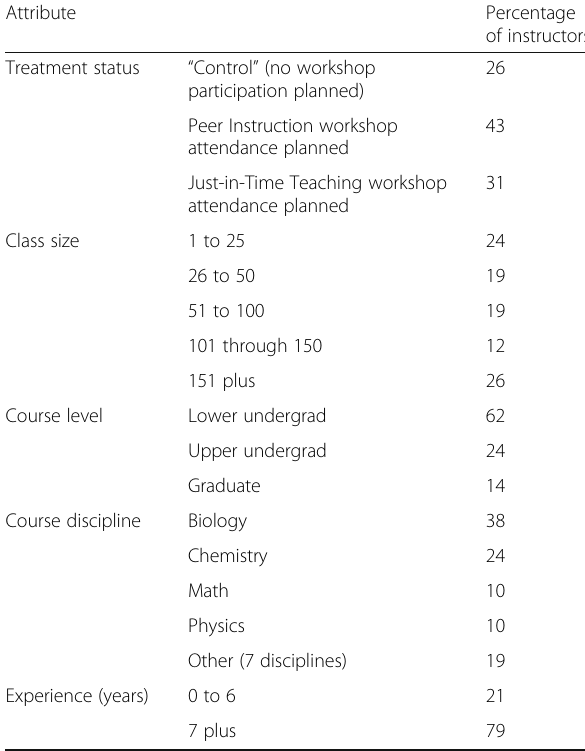
Table 1 Attributes of instructors under study ( n = 42) Attribute Treatment